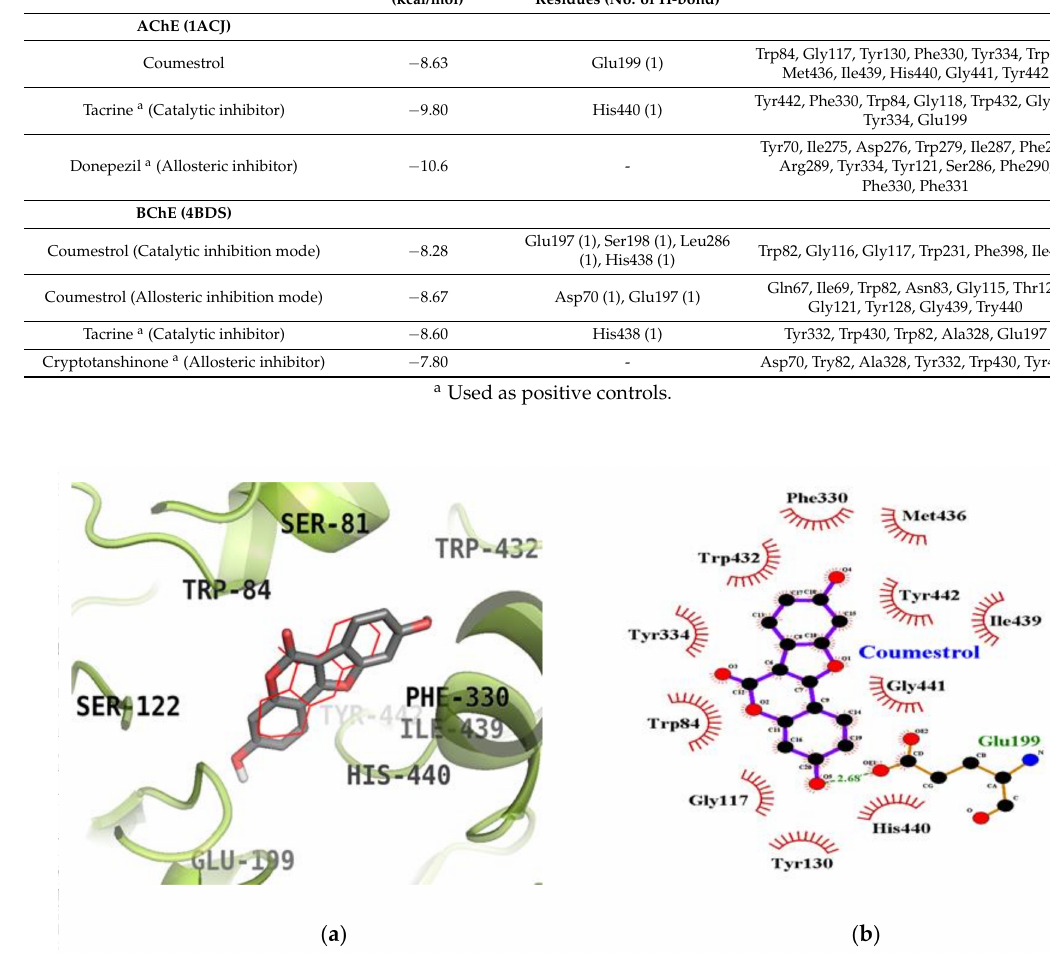
Figure 5. Inhibition mode of coumestrol for the AChE ( a ) catalytic site with tacrine (red line). 2D ligand interaction diagram of AChE inhibition by coumestrol ( b ). Dashed lines indicate H-bonds. Carbons are in black, nitrogens in blue, and oxygens in